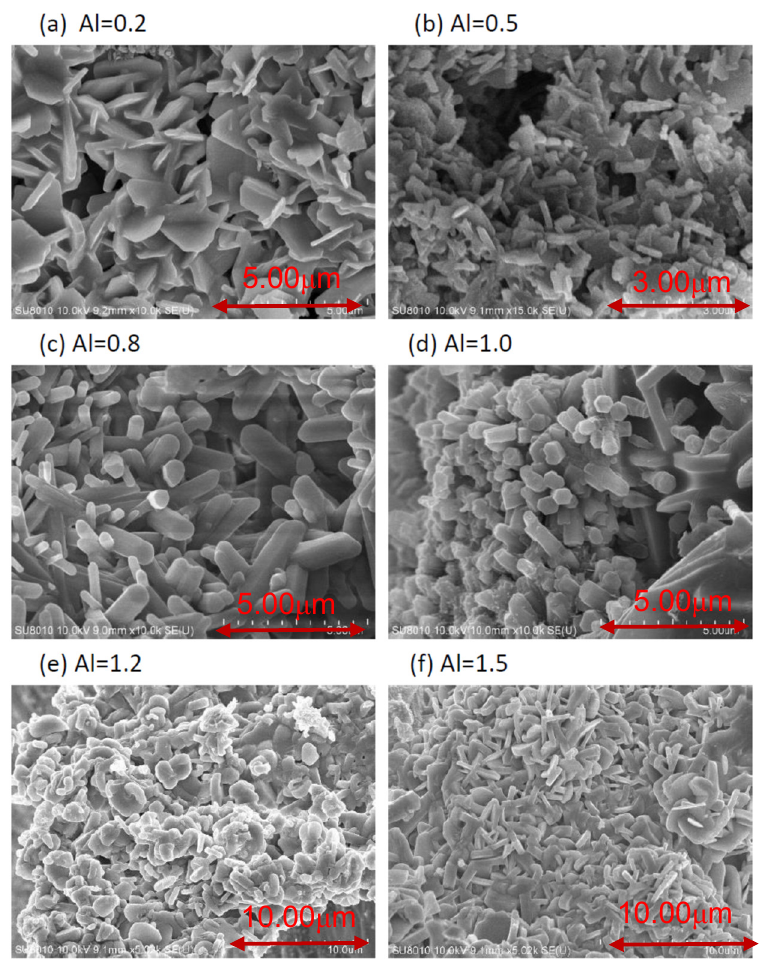
Figure 2. A typical SEM photograph of the products obtained with Al = 0.2 ( a ); 0.5 ( b ); 0.8 ( c ); 1.0 ( d ); 1.2 ( e ); and 1.5 ( f ).